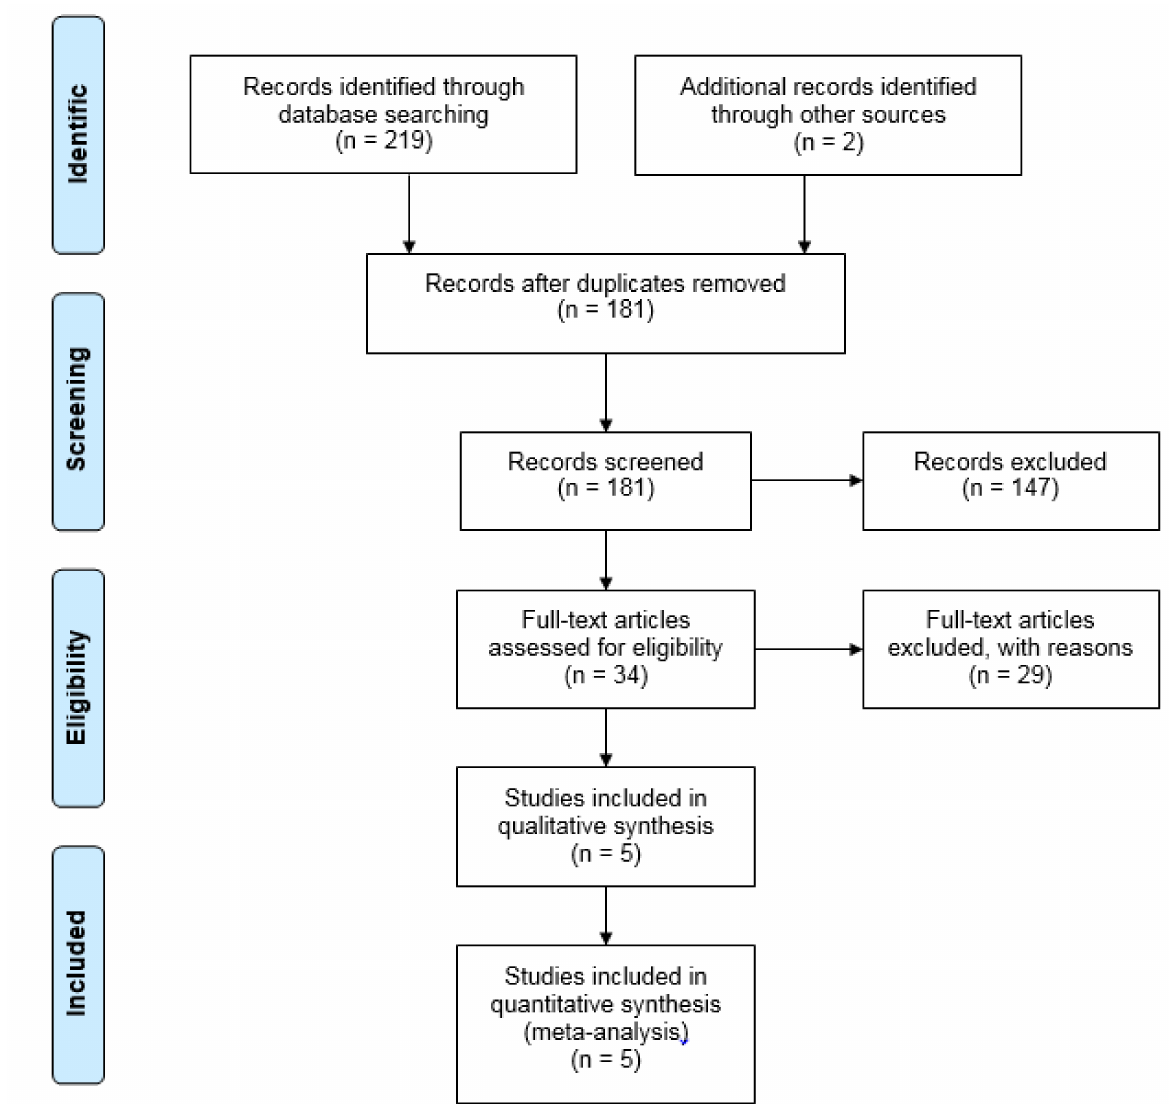
Figure 1. Flow diagram of selecting articles for systematical review of the effect of mipomersen on the management of familial